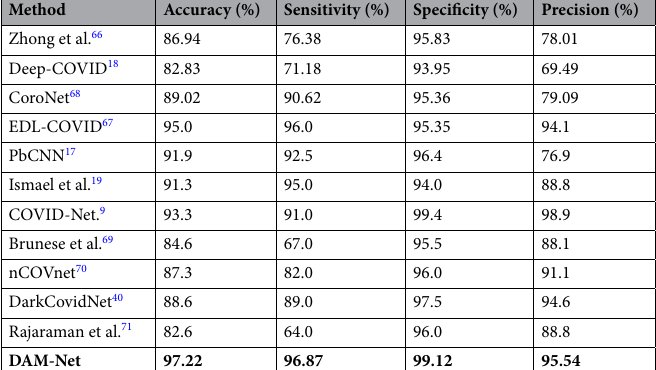
Table 1. Comparison of our proposed method with existing state-of-the-art methods using COVIDx dataset, the best performances are indicated in bold.